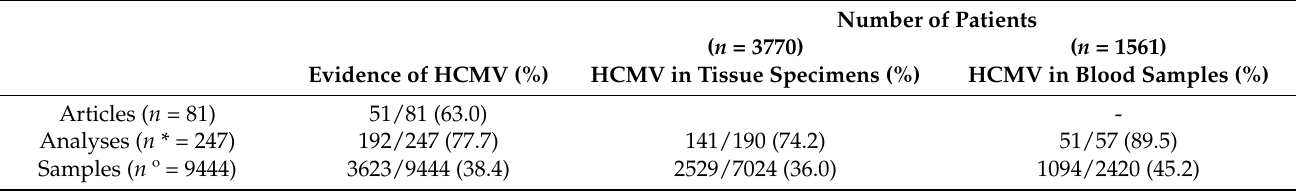
Table 1. Total number of reviewed studies, patients, and results regarding the detection of HCMV in tissue specimens and blood samples obtained from GBM